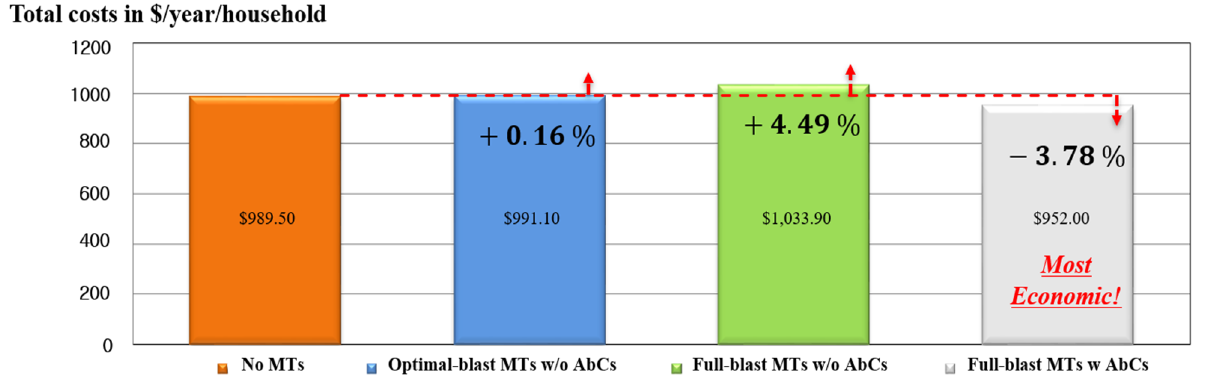
Figure 14. Total cost savings (Gas = 0.1155 $/m 3 ; scenario 2). Table 4. MT life-cycle cost.